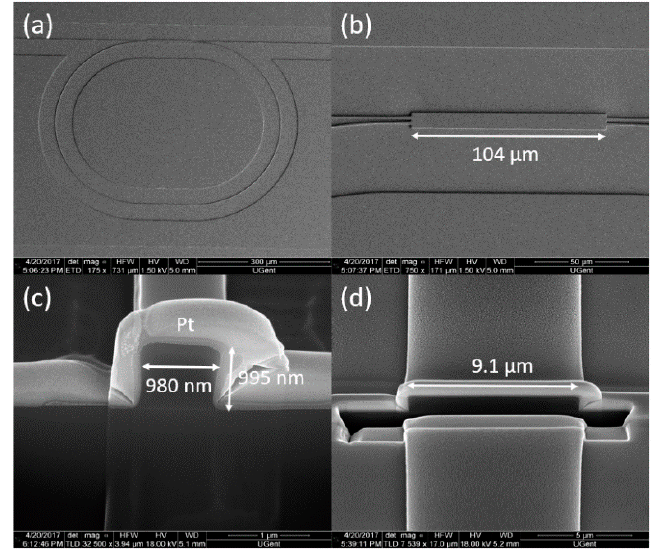
Figure 7. ( a ) Top view of the whole microring resonator; ( b ) Top view of the MMI coupler; ( c )